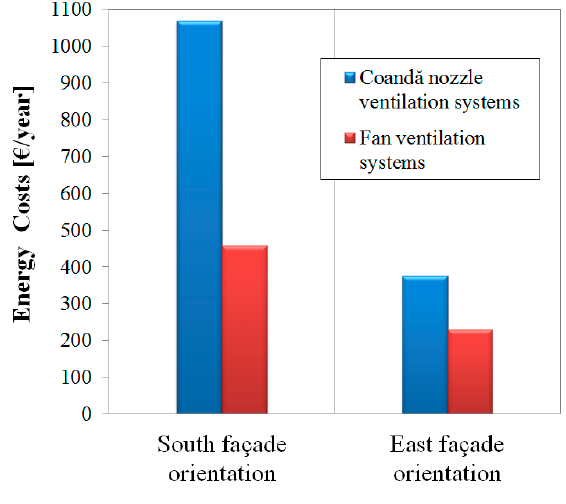
Figure 7. Operating costs of Coand ă nozzle ventilation system in comparison with fan ventilation system for different façades